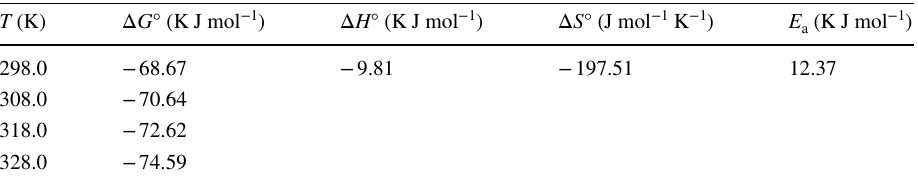
Fig. 8 The plot of lnk